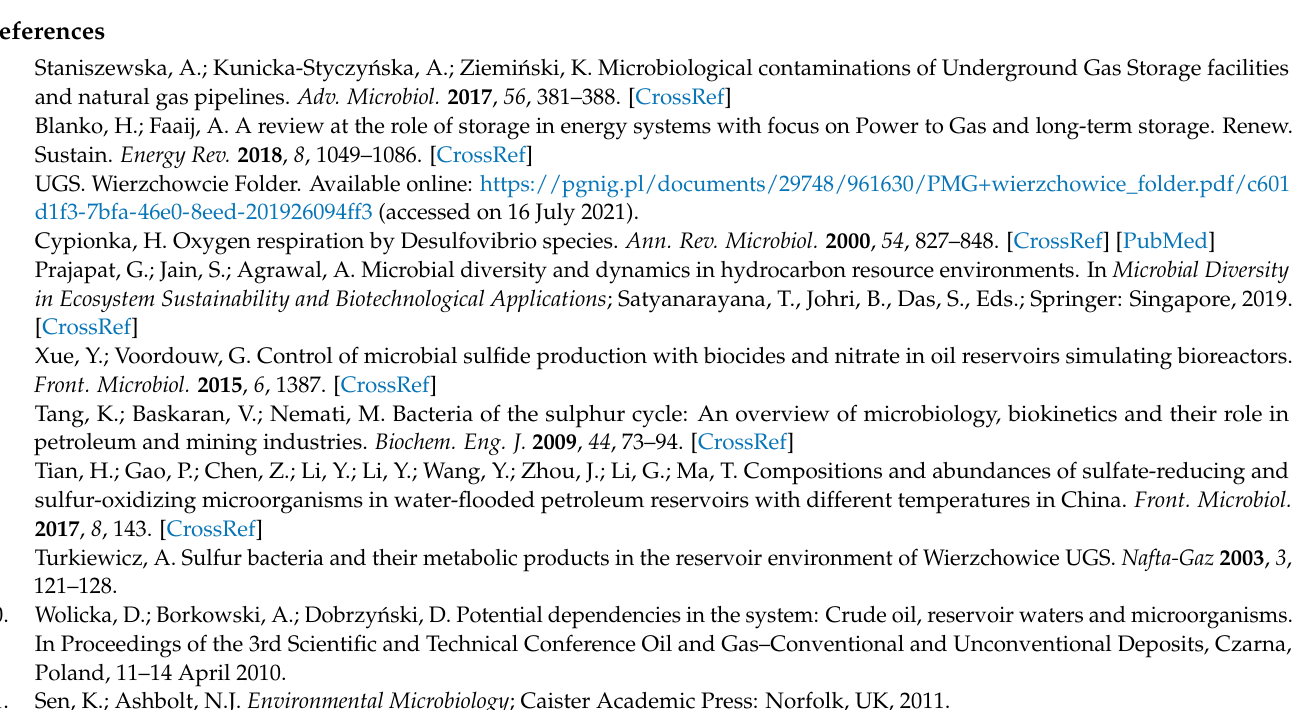
Table S2: The content of sulphur compounds in natural gas from selected horizontal wells in clusters A and B of the Wierzchowice Underground Gas Storage facility in the XXV UGS exploitation cycle (II series—15 January 2020; gas depletion from the UGS facility: 497 million Nm 3 ), Table S3: The content of sulphur compounds in natural gas from selected horizontal wells in clusters A and B of the Wierzchowice Underground Gas Storage facility in the XXV exploitation cycle (II series—15 January 2020; gas depletion from the UGS facility: 750 million Nm 3 ), Table S4. A comparison of hydrogen sulphide content in natural gas from horizontal wells in clusters A and B of the Wierzchowice Underground Gas Storage facility (III series of tests), Figure S1. Scheme of biomonitoring studies, Figure S2. Diagram illustrating the theoretical possibilities of hydrogen sulphide